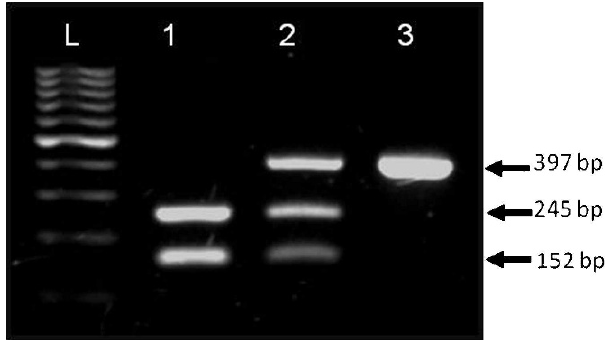
Figure 1 - The electrophoretic profile of the fragment of 397 base pairs (bp) of exon 1 of the ADA gene after digestion with the Taq